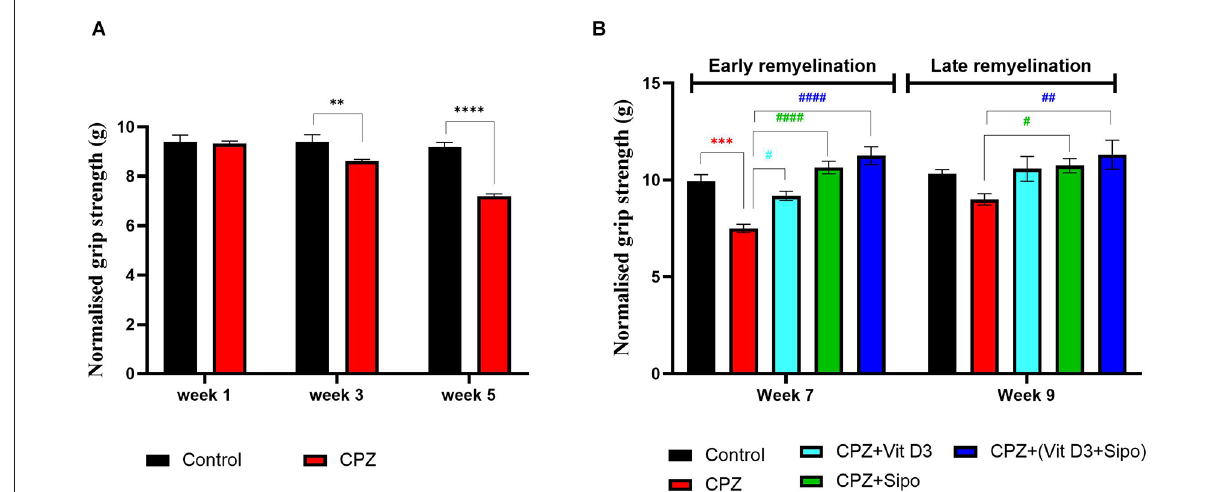
FIGURE4 Grip strength test. (A) Effects of CPZ on the grip strength during demyelination stage. (B) Effects of different treatments on the mice grip strength during (early and late) remyelination stages. Data are represented as the mean ± SEM, and two-way ANOVA was used followed by Šídák’s and Tukey’s multiple comparisons tests (A,B) were used, respectively. CPZ, cuprizone; Vit D3, vitamin D3; Sipo: siponimod. ( ∗ ) Indicates a significant difference vs. the control group; ( # ) indicates a significant difference vs. CPZ group. ∗∗ p < 0.01, ∗∗∗ p < 0.001, ∗∗∗∗ p < 0.0001, # p < 0.05, ## p < 0.01 and #### p < 0.0001.